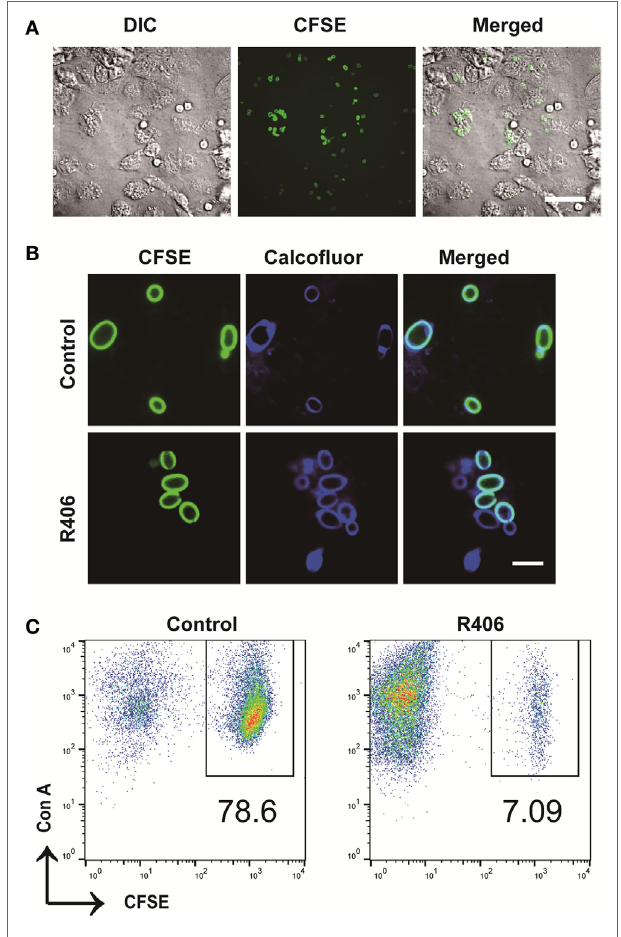
FigUre 3 | Spleen tyrosine kinase is required for peritoneal macrophage control of Candida glabrata . (a) Differential interference contrast (DIC) and fluorescence microscopy image of carboxyfluorescein succinimidyl ester (CFSE)- C. glabrata and macrophage after 1 h of coculture indicating complete uptake of the yeast by the macrophages. Scale bar represents 50 μ m. (B) DIC and fluorescence microscopy image of CFSE C. glabrata infected macrophages 16 h post inoculation. Macrophages control C. glabrata division in CFSE-bright undivided state, while treatment with R406 impaired the macrophages’ ability in controlling C. glabrata . Scale bar represents 5 µm. (c) Flow cytometry scatter plots of Con A and CFSE showing macrophage controlling C. glabrata division and loss of control in R406-treated cells. Data represent three independent